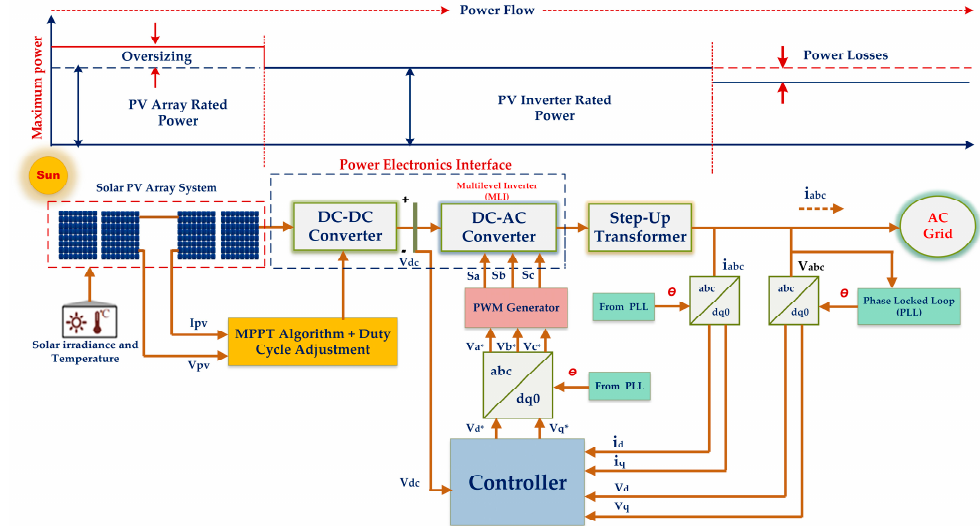
Figure 27. Oversized PV arrays in a grid-connected PV system.